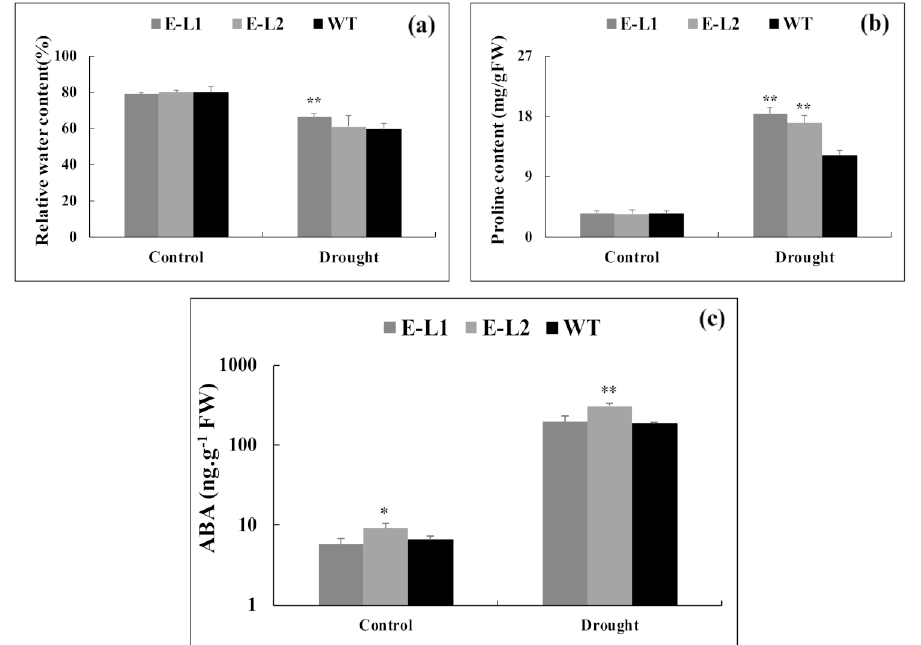
Figure 12. TgERF1 transgenic and WT tobacco plants in response to drought stress. ( a ) Relative water content. ( b ) Proline. ( c ) Endogenous ABA concentration. Plants were grown in individual pots, watered with one-fifth-strength Hoagland solution and weighed daily during the